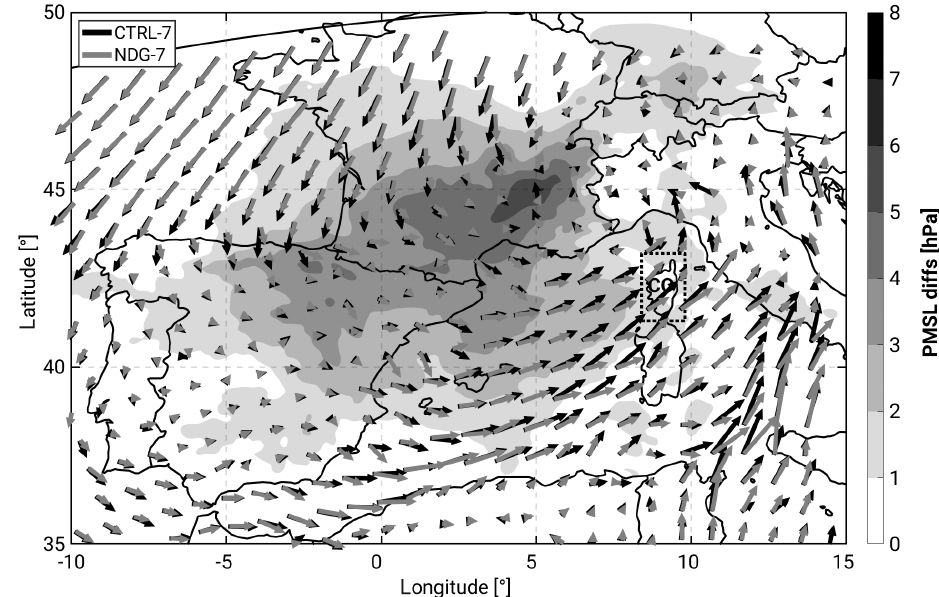
Figure 13. Spatial distribution of the differences in pressure at mean sea level (PMSL) between NDG-7 and CTRL-7 on 26 October at 23:00UTC in a grey scale. Darker grey colours indicate larger PMSL in NDG-7. Horizontal winds at 950hPa are represented by black (CTRL-7) and grey (NDG-7) arrows. Table 3. Metrics for precipitation validation for the additional simulations initialized on 20 October 2012. A description of the metrics used can be found in the Appendix. (mm) Interp. to RG location Distributions without